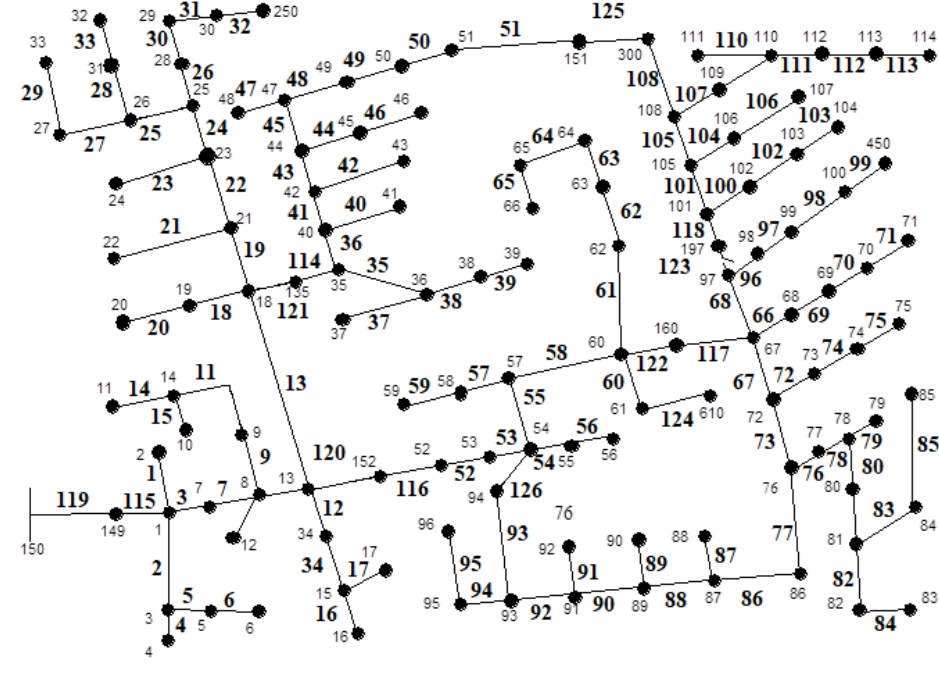
Figure 16. 123-bus modified